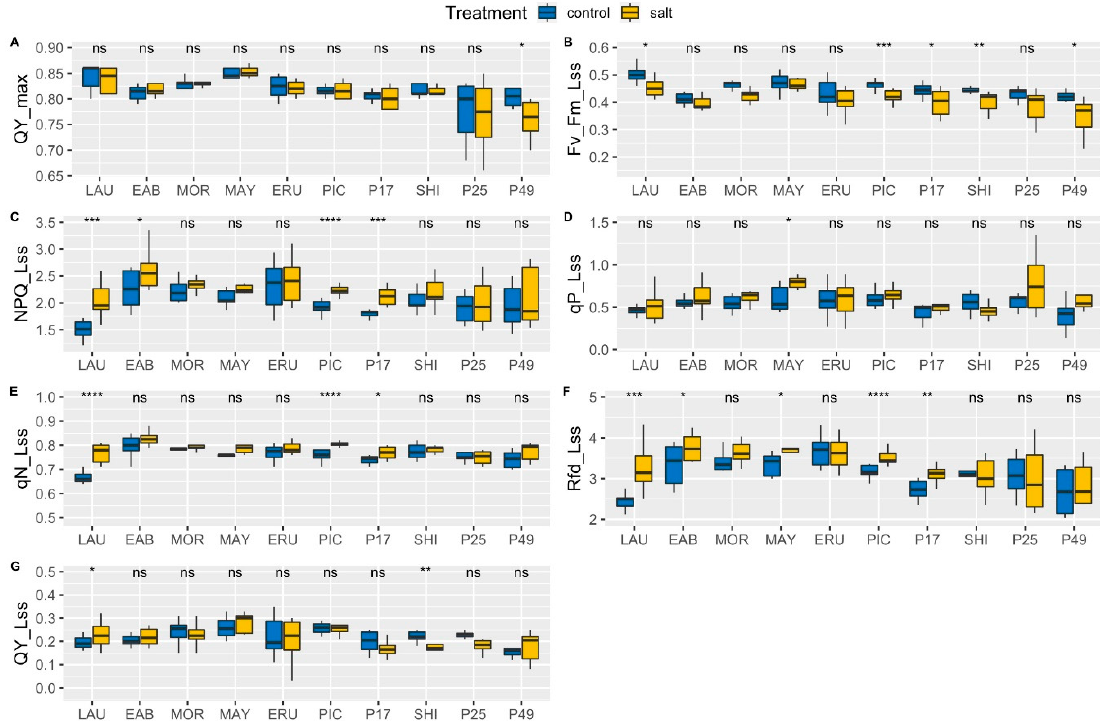
Figure 4. Analysis of chlorophyll fluorescence in salinity treated lettuce leaves. Chlorophyll fluorescence was measured using the PlantScreen phenotyping system and the FluorCam accessory. Values are means of two independent experiments, each with at least four biological replicates per cultivar / accession per condition. Fv / Fm or maximum quantum yield (QY_max) ( A ); Fv / Fm in steady state light (Fv_Fm_Lss) ( B ); non-photochemical quenching of maximum fluorescence in steady-state light (NPQ_Lss) ( C ); photochemical quenching in steady-state light (qP_Lss) ( D ); non-photochemical quenching of variable fluorescence in steady-state light (qN_Lss) ( E ); relative fluorescence decline in steady-state light (Rfd_Lss) ( F ); instantaneous photosystem II quantum yield in steady-state light (QY_Lss) ( G ). In above box plots, the boundary of the box closest to the x-axis indicates the 25th percentile, a black line within the box marks the median, and the boundary of the box farthest from the x-axis indicates the 75th percentile. Whiskers above and below the box indicate the 10th and 90th percentiles. Asterisks indicate statistical significance as calculated by the t -test. * ( p ≤ 0.05), ** ( p ≤ 0.01), *** ( p ≤ 0.001), **** ( p ≤ 0.0001), ns = not significant ( p > 0.05).